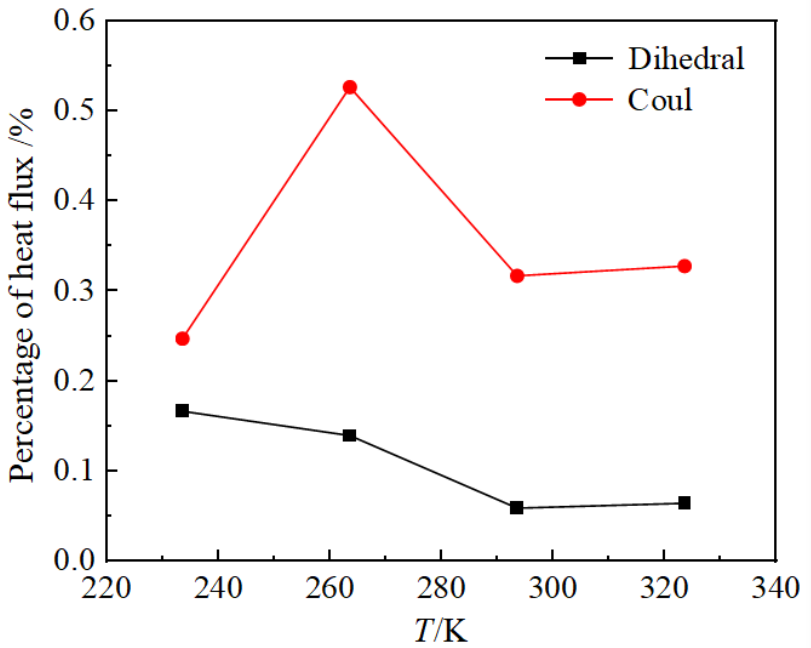
Figure 5. Contribution of energy transfer in dihedral and coul part to the total heat flux at different temperatures (C 2 H 5 OH).